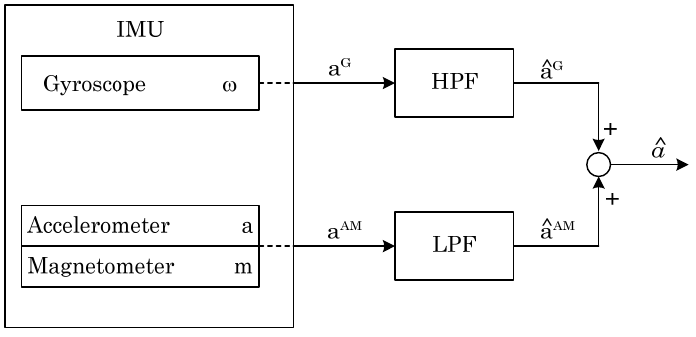
Figure 6. Processing of the IMU sensor data by the complementary filter.